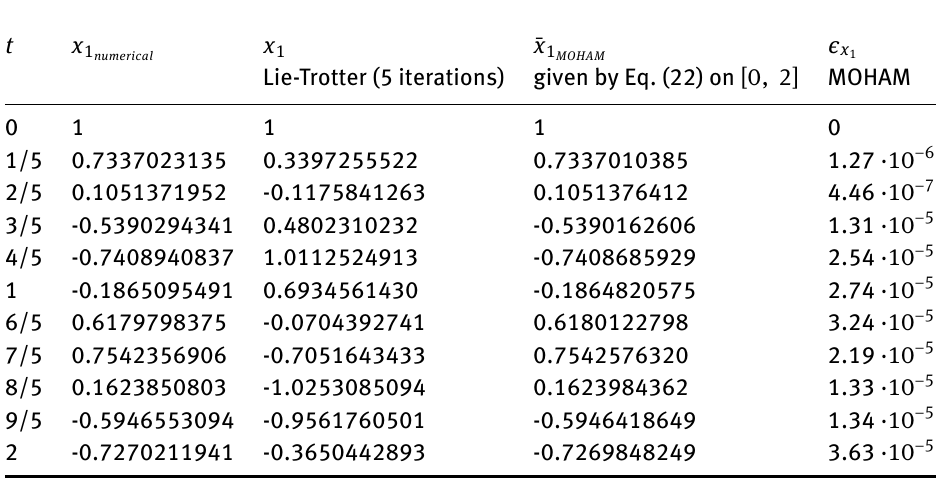
− ¯ x 1 | ) MOHAM numerical